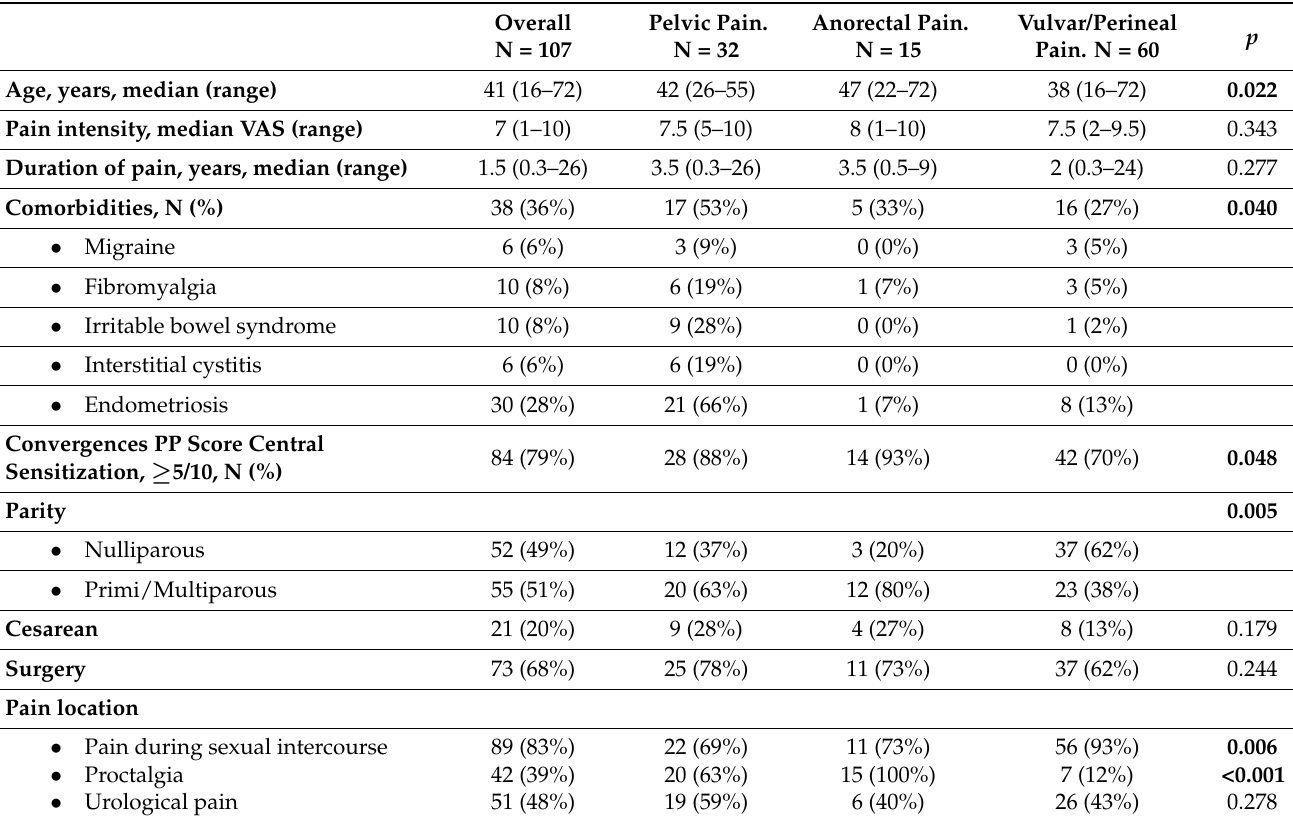
Table 1. Demographic characteristics of patients with endometrioses unresponsive to conventional therapy. Overall Pelvic N = 107